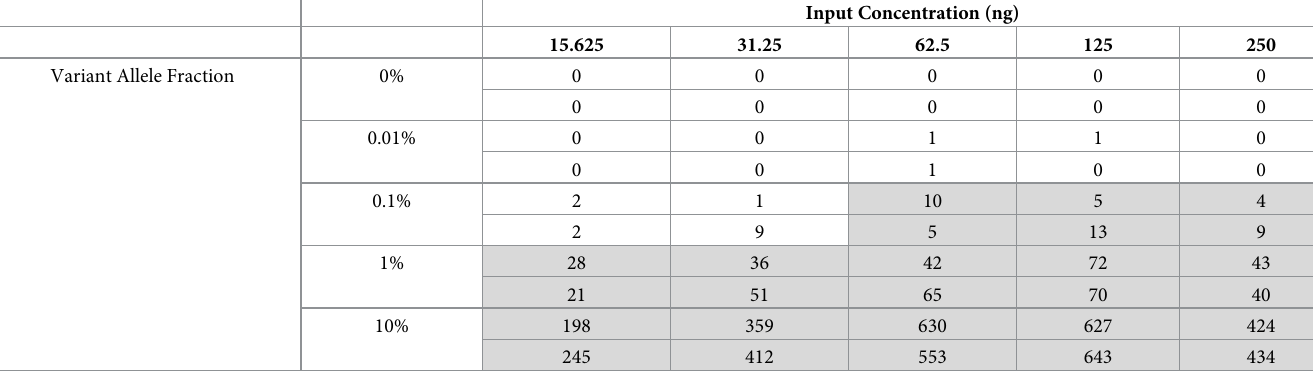
Table 3. Number of positive mutant events for EGFR exon 19 deletion reactions.